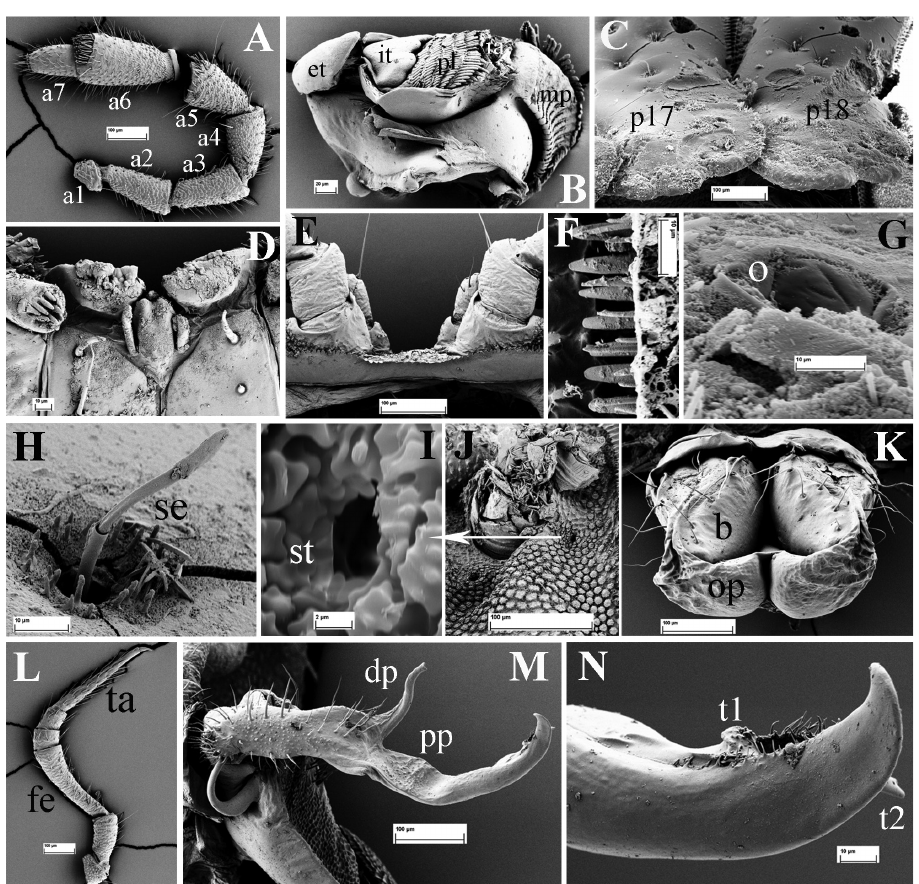
Figure 6. E. deporatus sp. n., SEM, male paratype from Cave Tham Pathok. A right antenna, lateral view (a1–a7 = antennomeres 1–7) B right mandible, general view (et = external tooth; it = internal tooth; pl = pectinate lamellae; ia = intermediate area; mp = molar plate) C paratergum 17 (p17) and 18 (p18), dorsal view D tip of gnathochilarium, ventral view E sternum 6, caudal view F limbus of metatergum 14, dorsal view G ozopore (o) on paratergum 17 H a seta (se) on metatergum 14, general view I stigmata (st), detail J stigmata of segment 17, subventral view K female paratype, vulvae, general view (op = operculum; b = bursa) L midbody leg, frontal view (fem = femur; ta = tarsus) M right gonopod, mesal view (dp = dist- ofemoral process; pp = papillate process) N tip of right gonopod, mesal view (t1–2 = teeth